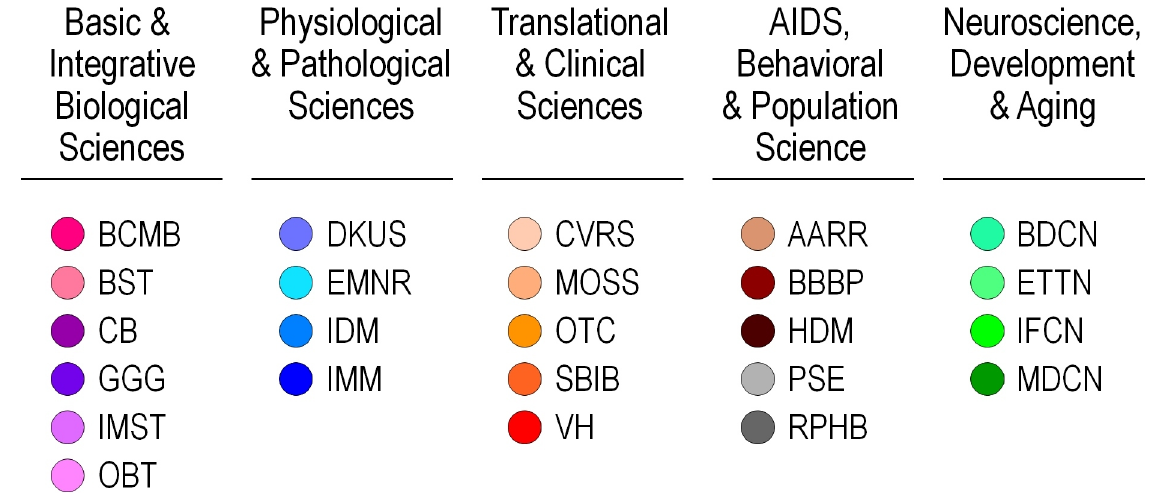
Figure 1. Listing of IRGs at CSR by Review Division. Each IRG has been assigned a color to be used in subsequent figures. Divisions are grouped by color. SRG to IRG assignments, acronyms and full names are provided in Appendix S1 and S2.